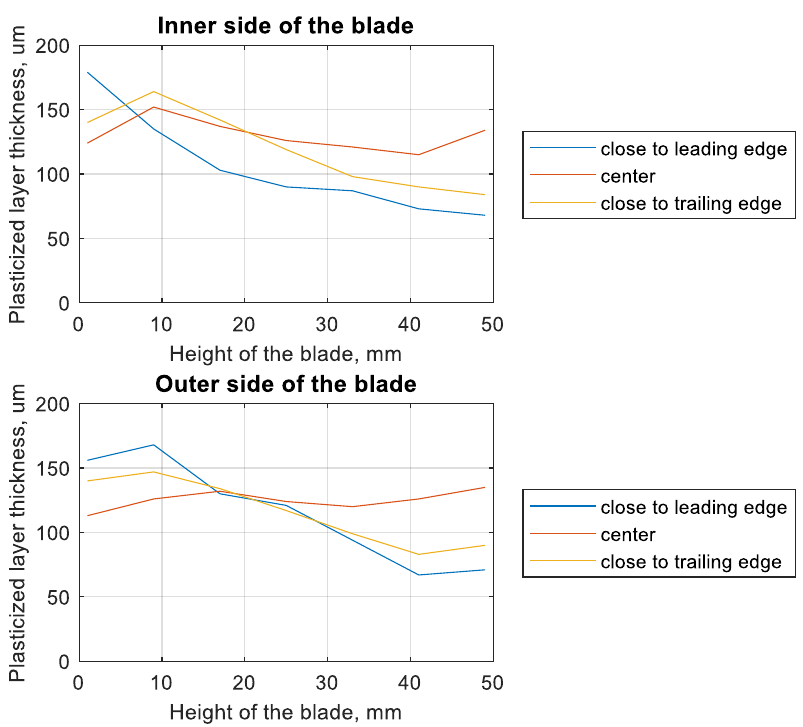
Figure 8. Plots of the grain size (in the layer plasticized by shot-peening) as a function of the height of the blade for different measurement locations.